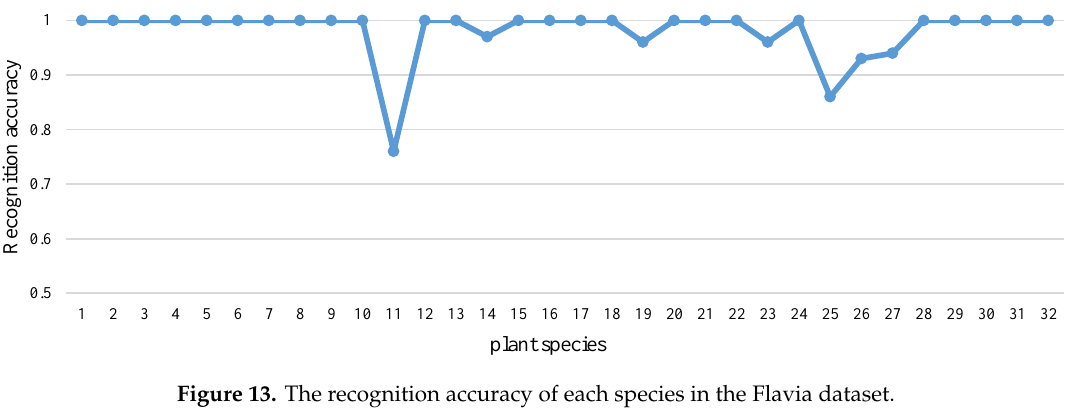
Table 1. Comparison of proposed feature with existing features on Flavia dataset.